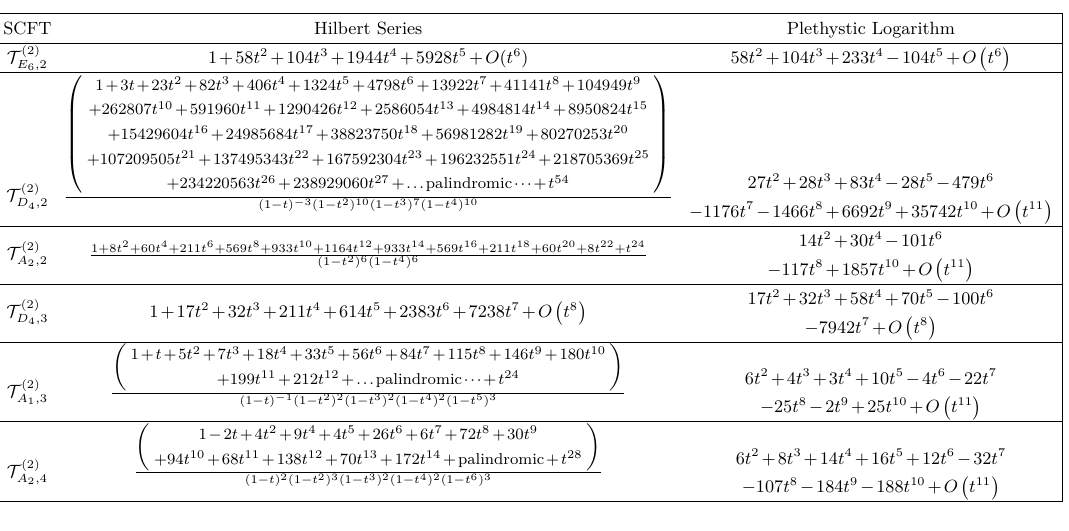
Table 5. Coulomb branch Hilbert series and plethystic logarithm for the magnetic quivers of the T ( r =2)